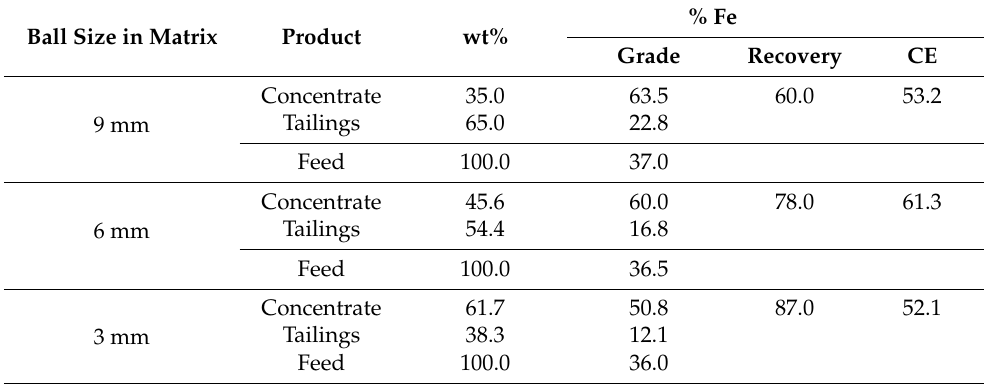
Table 4. Amenability to WHIMS by varying the ball matrix size.